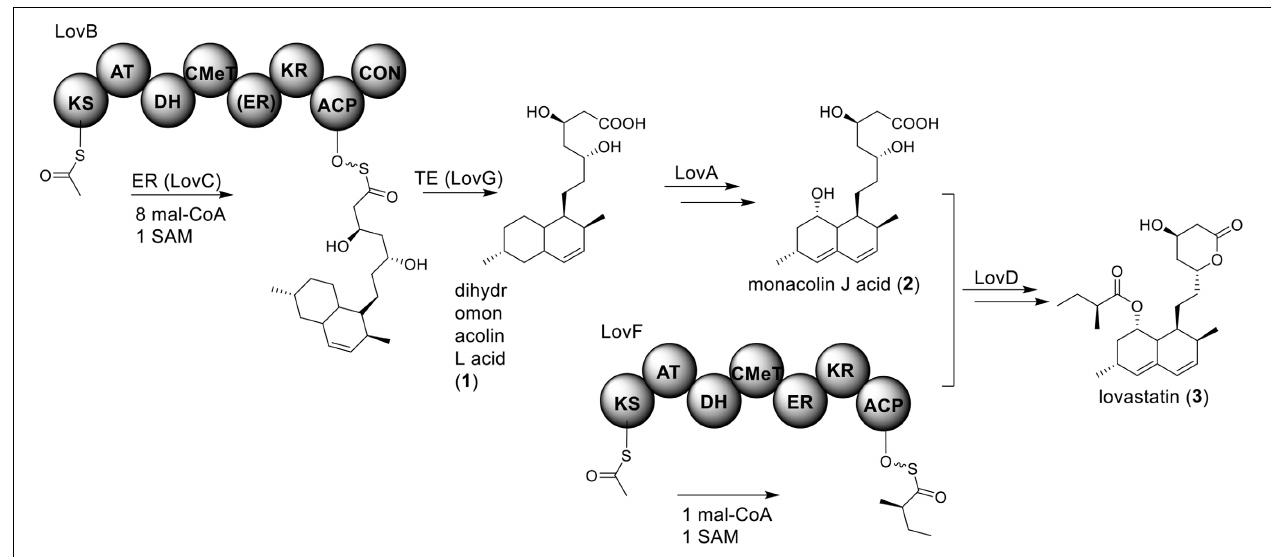
FIGURE 2 | Biosynthesis of lovastain in A. terreus